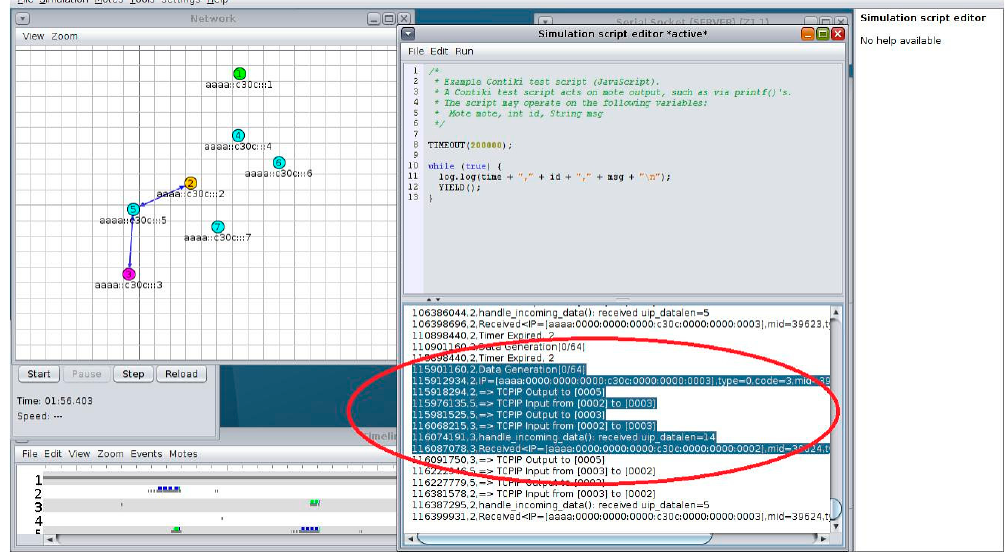
Figure 13. Direct Interaction of Sensor and Actuator Nodes in Cooja.